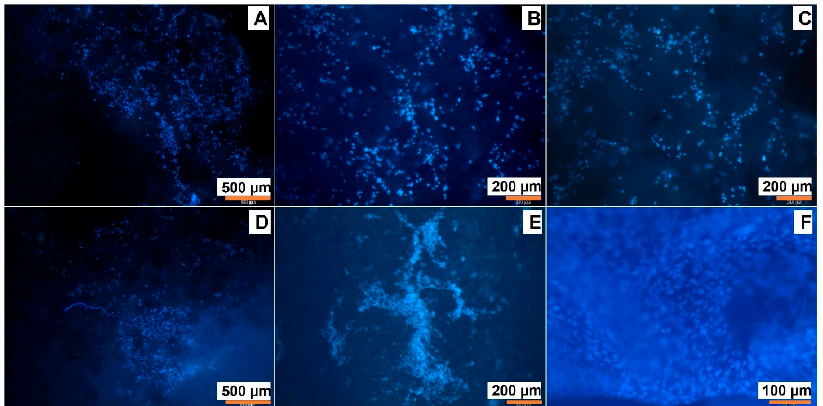
Figure 13. Fluorescent images of DAPI-stained mesenchymal stem cells (MSC) on the surface of: ( A – C )—cryogelated matrix PLA-MA/NCC-MA + 20% PEGDA; ( D – F ) 3D-printed matrix PLA- MA/NCC-MA + 20% GelMA. Images were recorded at different magnification: A and D × 2; B and E × 4; C and F ×